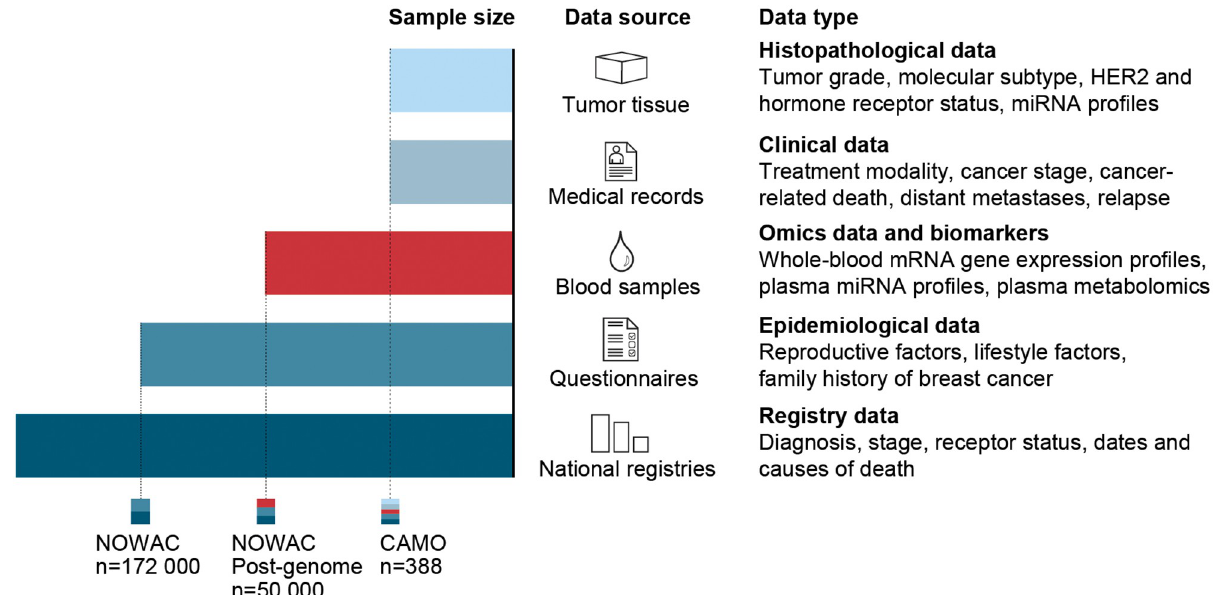
Fig 3. Overview of sample sizes, data sources, and data types. The Clinical and Multi-omic (CAMO) cohort, nested within the Norwegian Women and Cancer (NOWAC) study, provides multiple types of data from a wide range of sources, thereby enabling a systems epidemiology approach to breast cancer. These multimodal data may be combined in various ways to create complex study designs that can be used to investigate hypotheses related to breast cancer prevention, diagnostics, treatment, and survival.